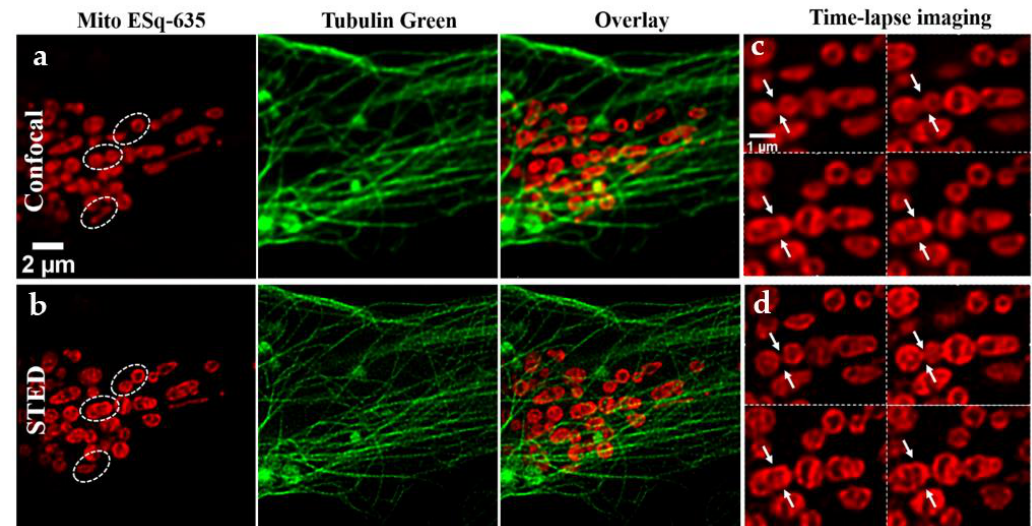
Figure 5. Long-term dynamic two-color imaging of U2OS cell. ( a ) Confocal image of mitochondria, tubulin, and their overlay. ( b ) STED image of mitochondria, tubulin, and their overlay after 12 min. ( c ) Confocal image of a typical mitochondrial fusion process, as indicated by the white arrow. ( d ) STED image of a typical mitochondrial fusion process, 3 min per frame. Scale bars: 2 and 1 μm.